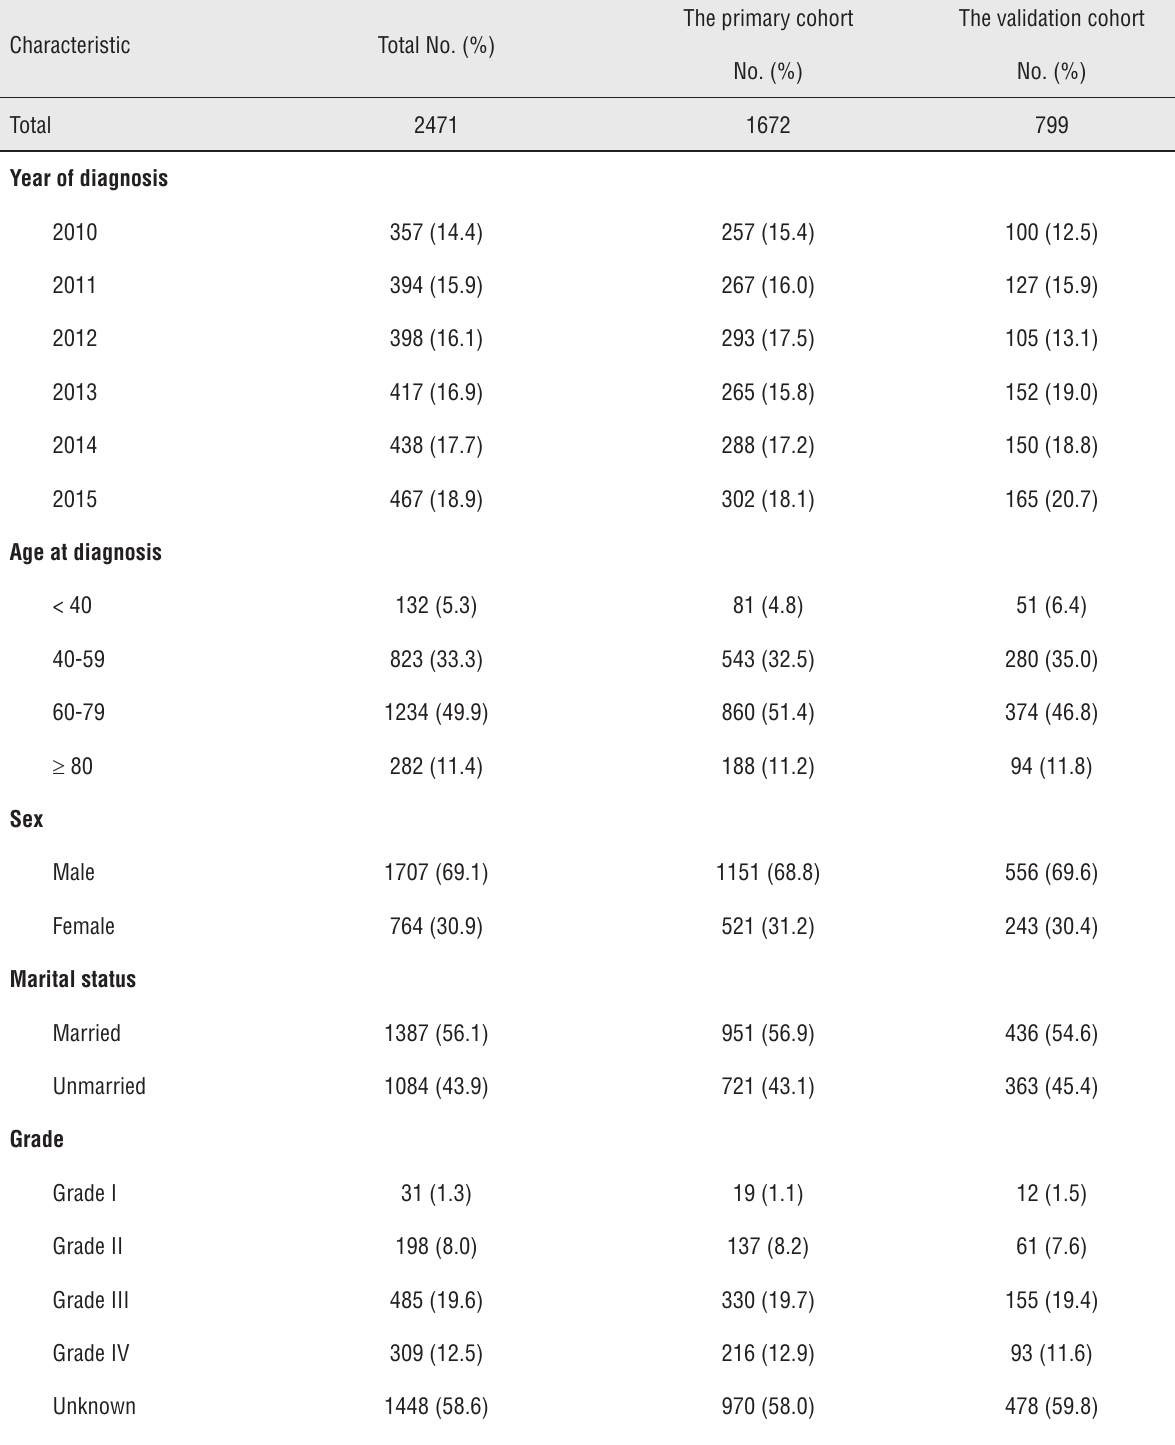
Table 1 - Baseline demographic and clinical characteristics with bone metastatic kidney cancer patients in our study.